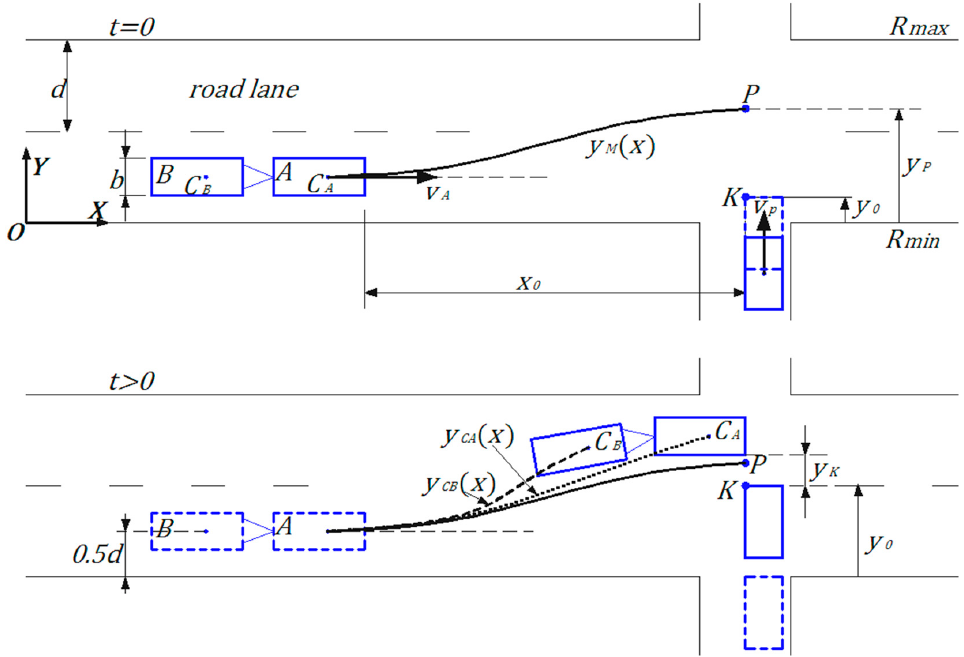
Figure 1. Road situation under analysis.